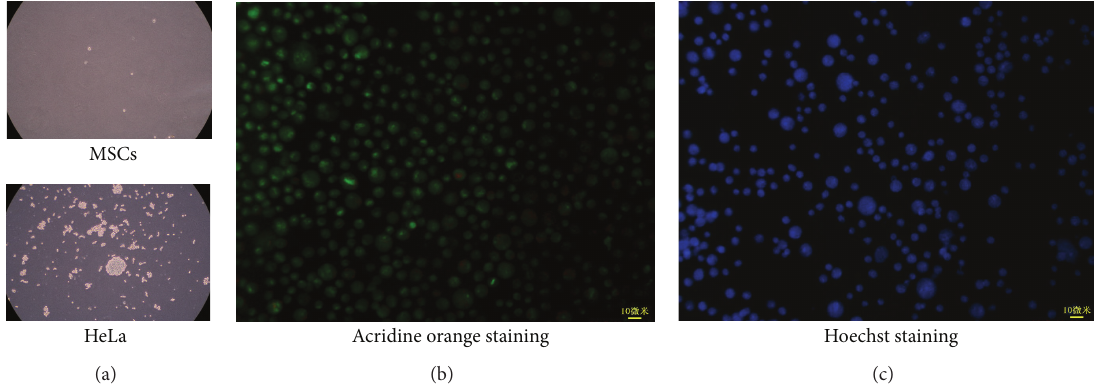
Figure 3: Cell quality of MSCs. MSCs were analyzed with agar cloning assay, acridine orange staining, and hoechst staining, respectively. In the cloning assay, MSCs showed no significant clones compared with HeLa (a). Acridine orange staining showed that only MSCs were stained indicating no fungal contamination (b). Hoechst 33258 staining showed that only MSCs were stained suggesting no mycoplasma contamination (c). This result was taken from one of the ten samples for patients.